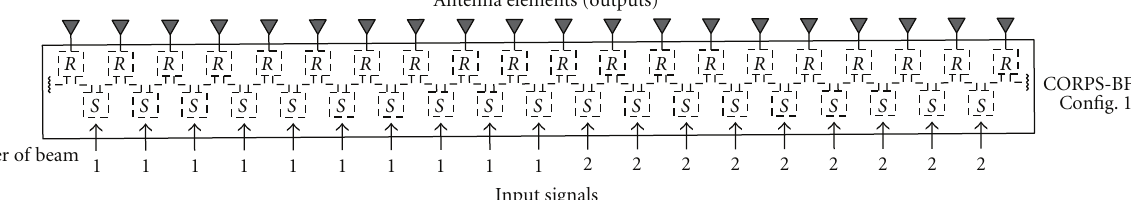
Figure 2: Configuration 1 of CORPS-BFN with 19 feeding ports and 20 antenna elements in a linear array considering 10 inputs × 11 outputs for beam no. 1 and 9 inputs × 10 outputs for beam no. 2.